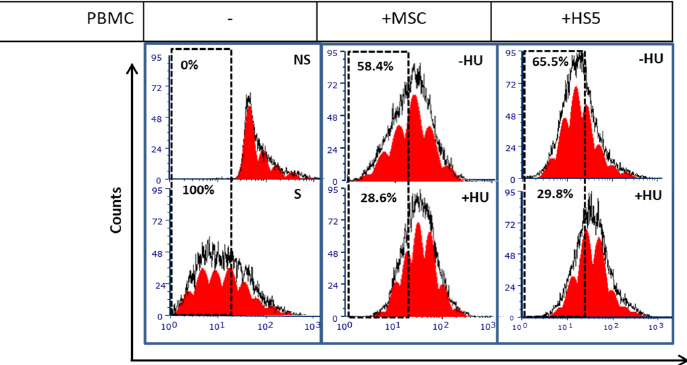
Figure 5. Hydroxyurea enhances the capacity of BMMSC to inhibit T-cell proliferation. BMMSC and HS-5 cell line were pre-treated for three days with 200 µ M of HU and subjected to co-culture conditions with CFSE-stained peripheral blood mononuclear cells stimulated with α CD3/CD28 micro-beads for five days. Then, CFSE cellular dilution indicating cellular duplication was analysed by flow cytometry. Experimental control without MSC refers to CFSE-stained PBMC alone under non- stimulated (NS) or stimulated (S) with α CD3/CD28 conditions. Results presented are representative from at least 3 performed experiments.